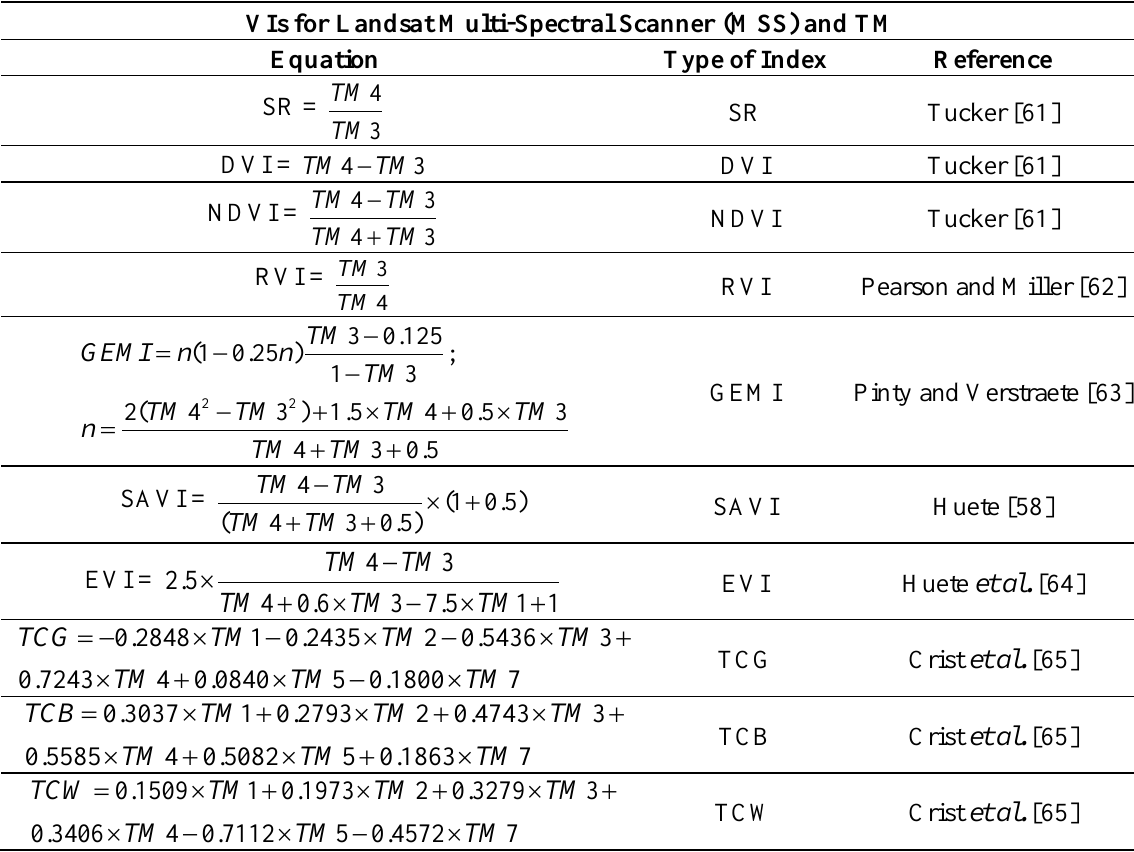
Table 2. The Landsat vegetation indices (Vis) used in this study. VIs for Landsat Multi-Spectral Scanner (MSS) and